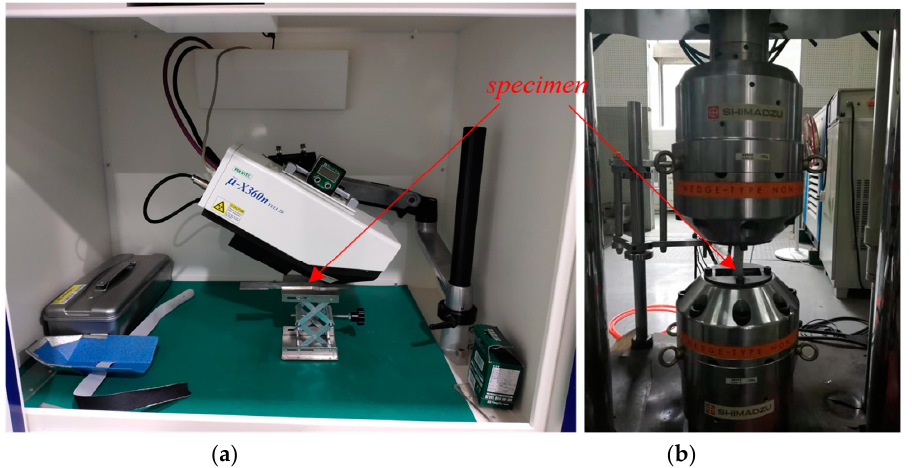
Figure 4. Experimental equipment: ( a ) µ -X360n X-ray diffractometer, residual stress measurement of specimens; ( b ) electro-hydraulic fatigue testing machine, tensile test of specimens. The titanium-based alloy specimens, the lower end of which is fixed on the clamping end and the upper end of which is fixed on the load end, was installed vertically on the fatigue testing machine.